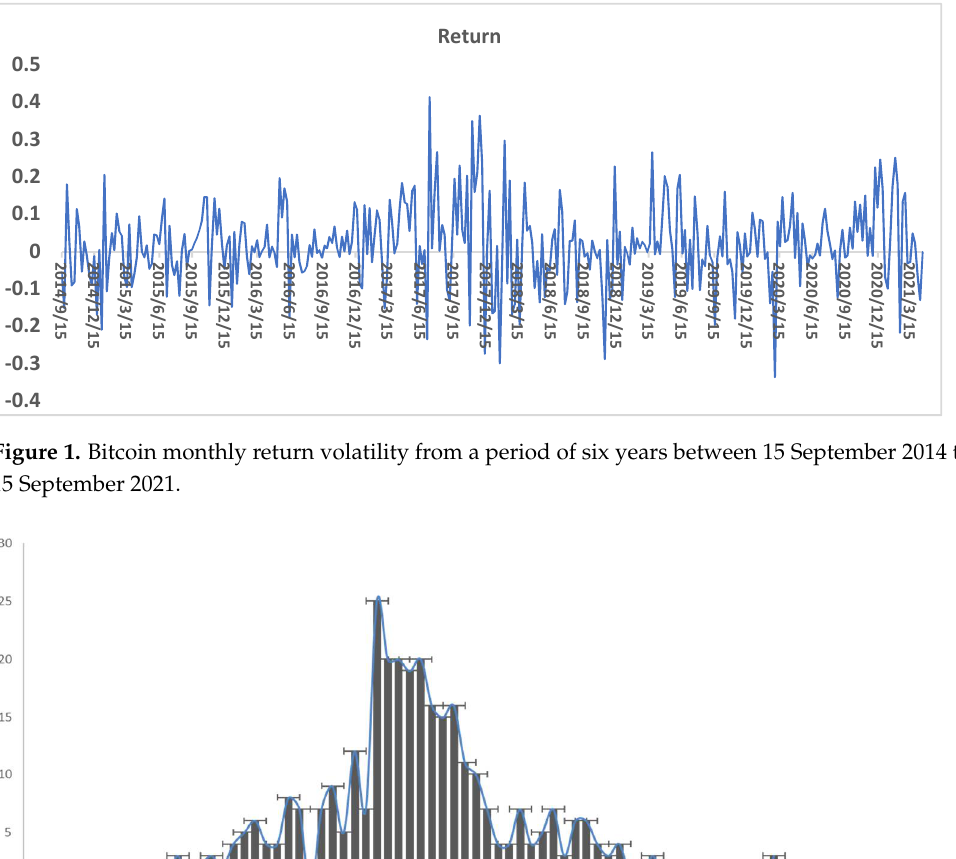
Figure 3. Volatility observations between monthly price changes of four financial investments between 2019 before the COVID outbreak to 2021. 3.7. Major Price Crashes of Bitcoin Even though Bitcoin came into existence in 2009, it was a relatively unknown entity and not widely traded or held until 2017. Its price skyrocketed in 2017 virtually taking it into bubble territory. A big crash soon ensued in which price came down by approxi- mately 90% in the next year. Here is a list of large price crashes in the short history of 12 years of Bitcoin and the circumstances surrounding them. Mt. Gox, a leading cryptocurrency exchange experienced the highest volumes of trading of all time. Hence the servers slowed and had to be shut down for 8 h creating a panic on top of the preceding price rally in Bitcoin led to a crash as people suspected their money may go to some unknown location and cannot be retrieved. They simply dumped Bitcoin and the price fell 80%. After the unprecedented rally in 2017, governments started